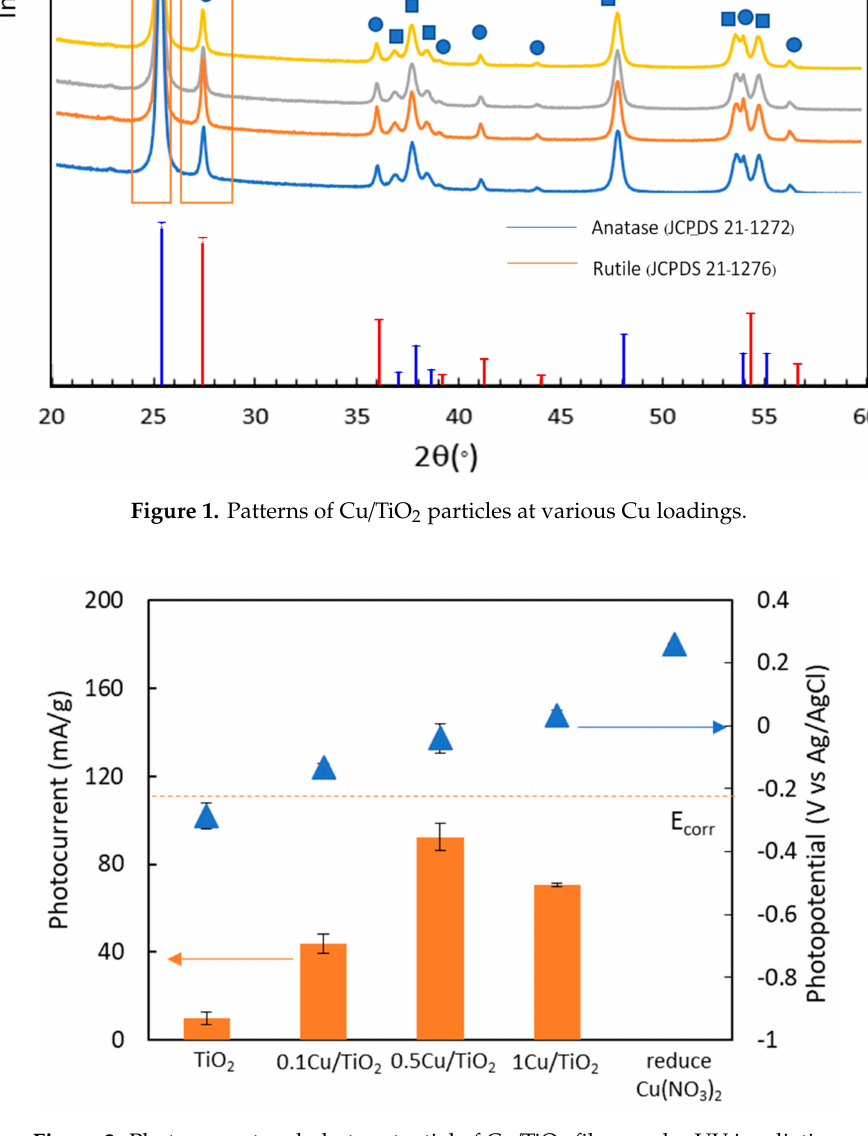
Figure 2. Photocurrent and photopotential of Cu / TiO 2 films under UV